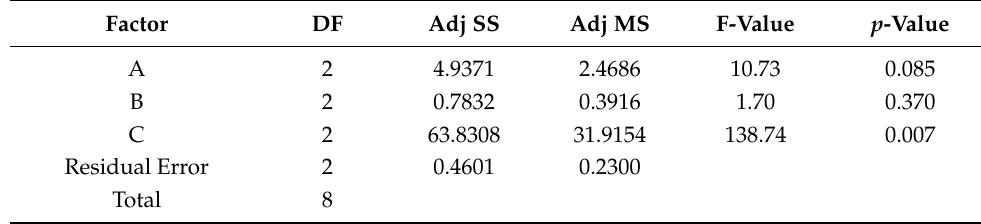
Table 4. Analysis of variance for the three factors A, B, and